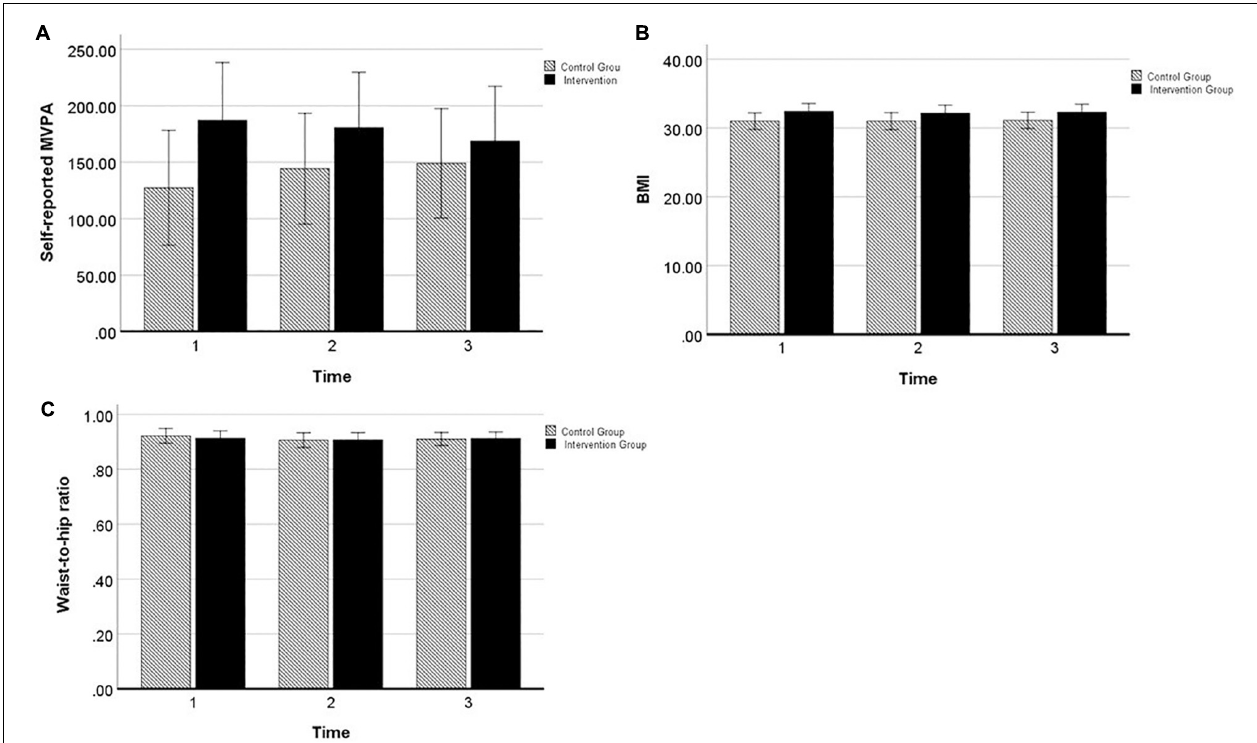
FIGURE 3 | Profile plots from two-way mixed ANOVA’s of estimated marginal means of partners’ (A) self-reported MVPA, (B) BMI, and (C) waist-to-hip ratio, displayed for intervention group (black) and control group (black–white striped) with 95% confidence interval error